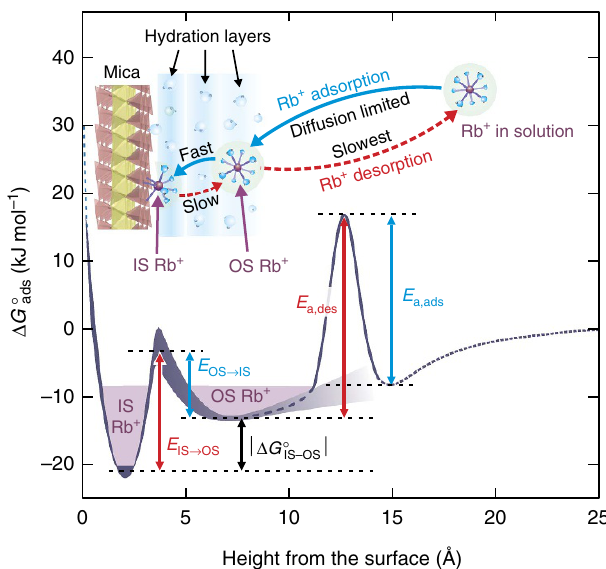
Figure 6 | Free energy profile for Rb þ adsorbed at the muscovite mica (001)–water interface. The free energy profile ( D G (cid:2) ads ) is computed as a function of height ( z ) up to B 10Å using the electron-density profile of adsorbed Rb þ reported previously 22 (Supplementary Note 5). The thickness of the line corresponds to one s.d. of uncertainty 65 of the free energy in units of kJmol (cid:2) 1 . The D G (cid:2) ads for z - N was set to 0 (Supplementary Note 5). The activation energies for the transition from IS to OS Rb þ and from OS to IS Rb þ are labelled E IS - OS and E OS - IS , respectively. D G (cid:2) IS–OS is the difference in free energy of adsorption between IS and OS Rb þ . The activation energies for Rb þ desorption and adsorption are labelled as E a,des and E a,ads , respectively. The top schematic shows the stepwise pathways for adsorption and desorption of Rb þ (indicated with blue and red arrows, respectively) at the